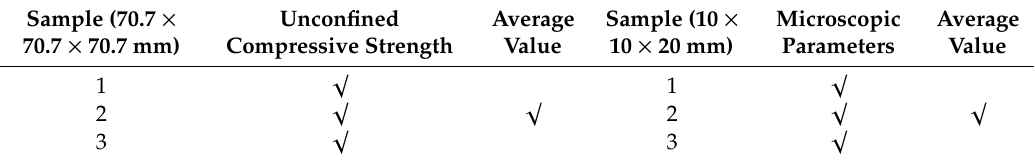
Figure 1. The entire experimental process. Table 2. The experimental scheme for each curing age and curing agent content. Sample (70.7 ×